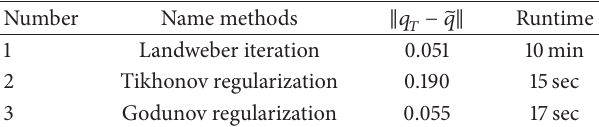
Figure 6: 󳶃 indicates exact solution 𝑞(𝑦) ; e indicates Landweber iteration; ◼ indicates Tikhonov regularization; 󳵳 indicates Godunov regularization. Table6:Comparativeanalysisofmethodsinthecaseofnoisewithin 1%.